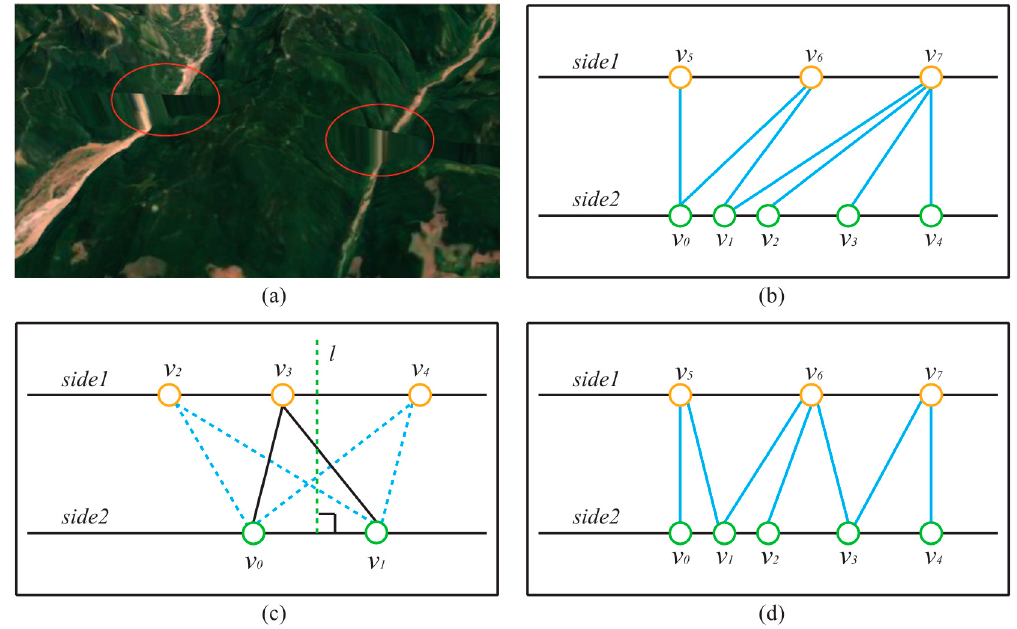
Figure 8. Triangulation of DSS: ( a ) Artefacts caused by thin triangles. ( b ) Connect the vertices sequentially. ( c ) The principle of our triangulation algorithm. ( d ) Connect the vertices based on our method. Algorithm 1 Dynamic Stitching Strip Triangulation